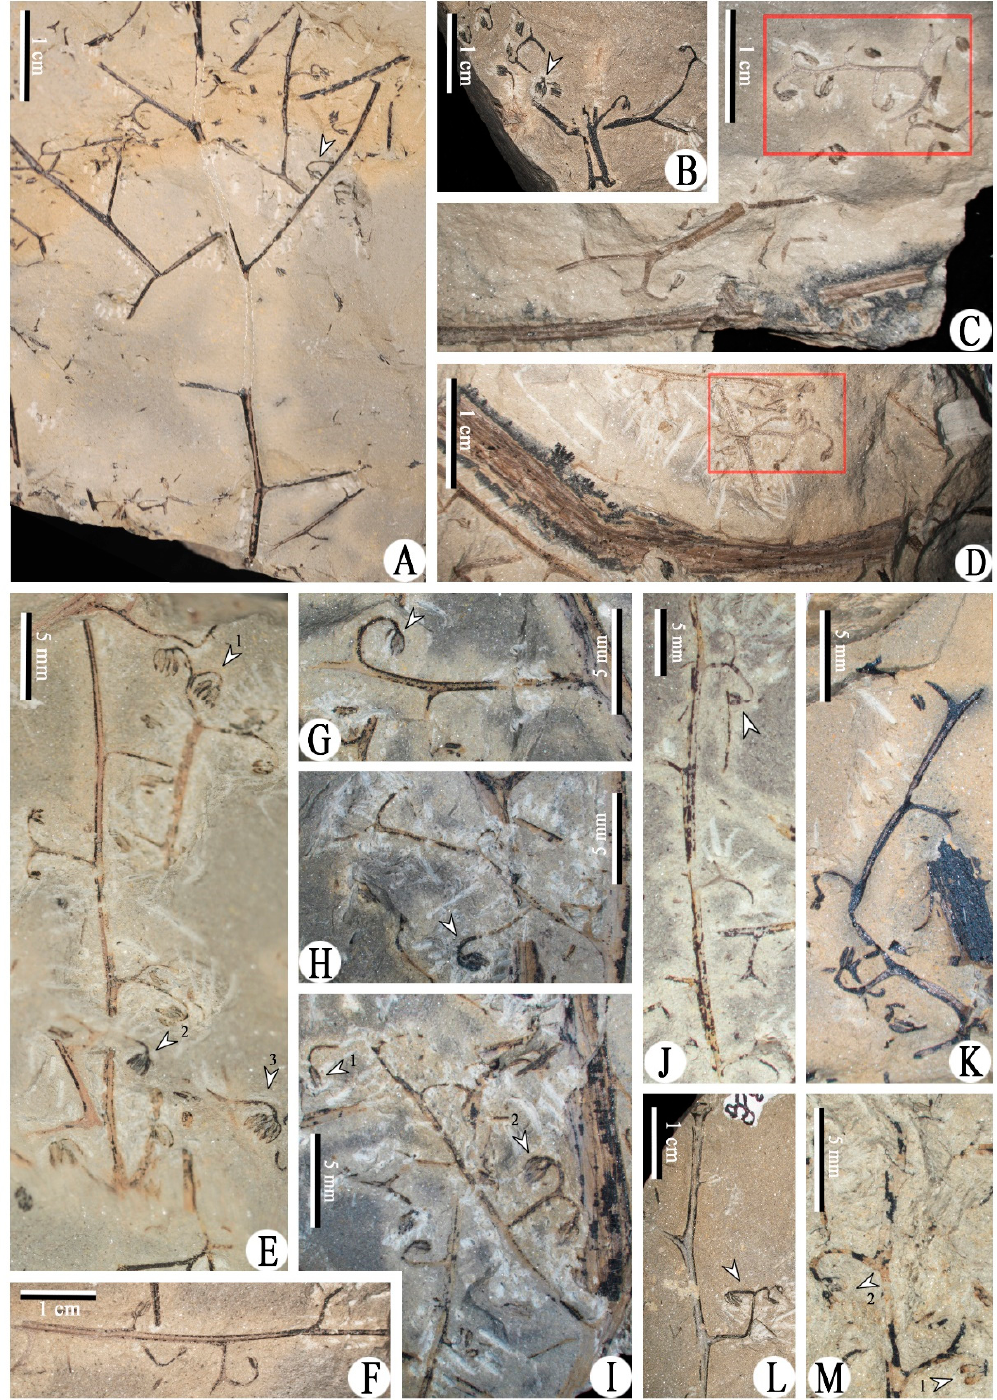
Figure 4. Morphology of Xinhangia spina gen. et sp. nov. from Guangde City, Anhui Province, China.